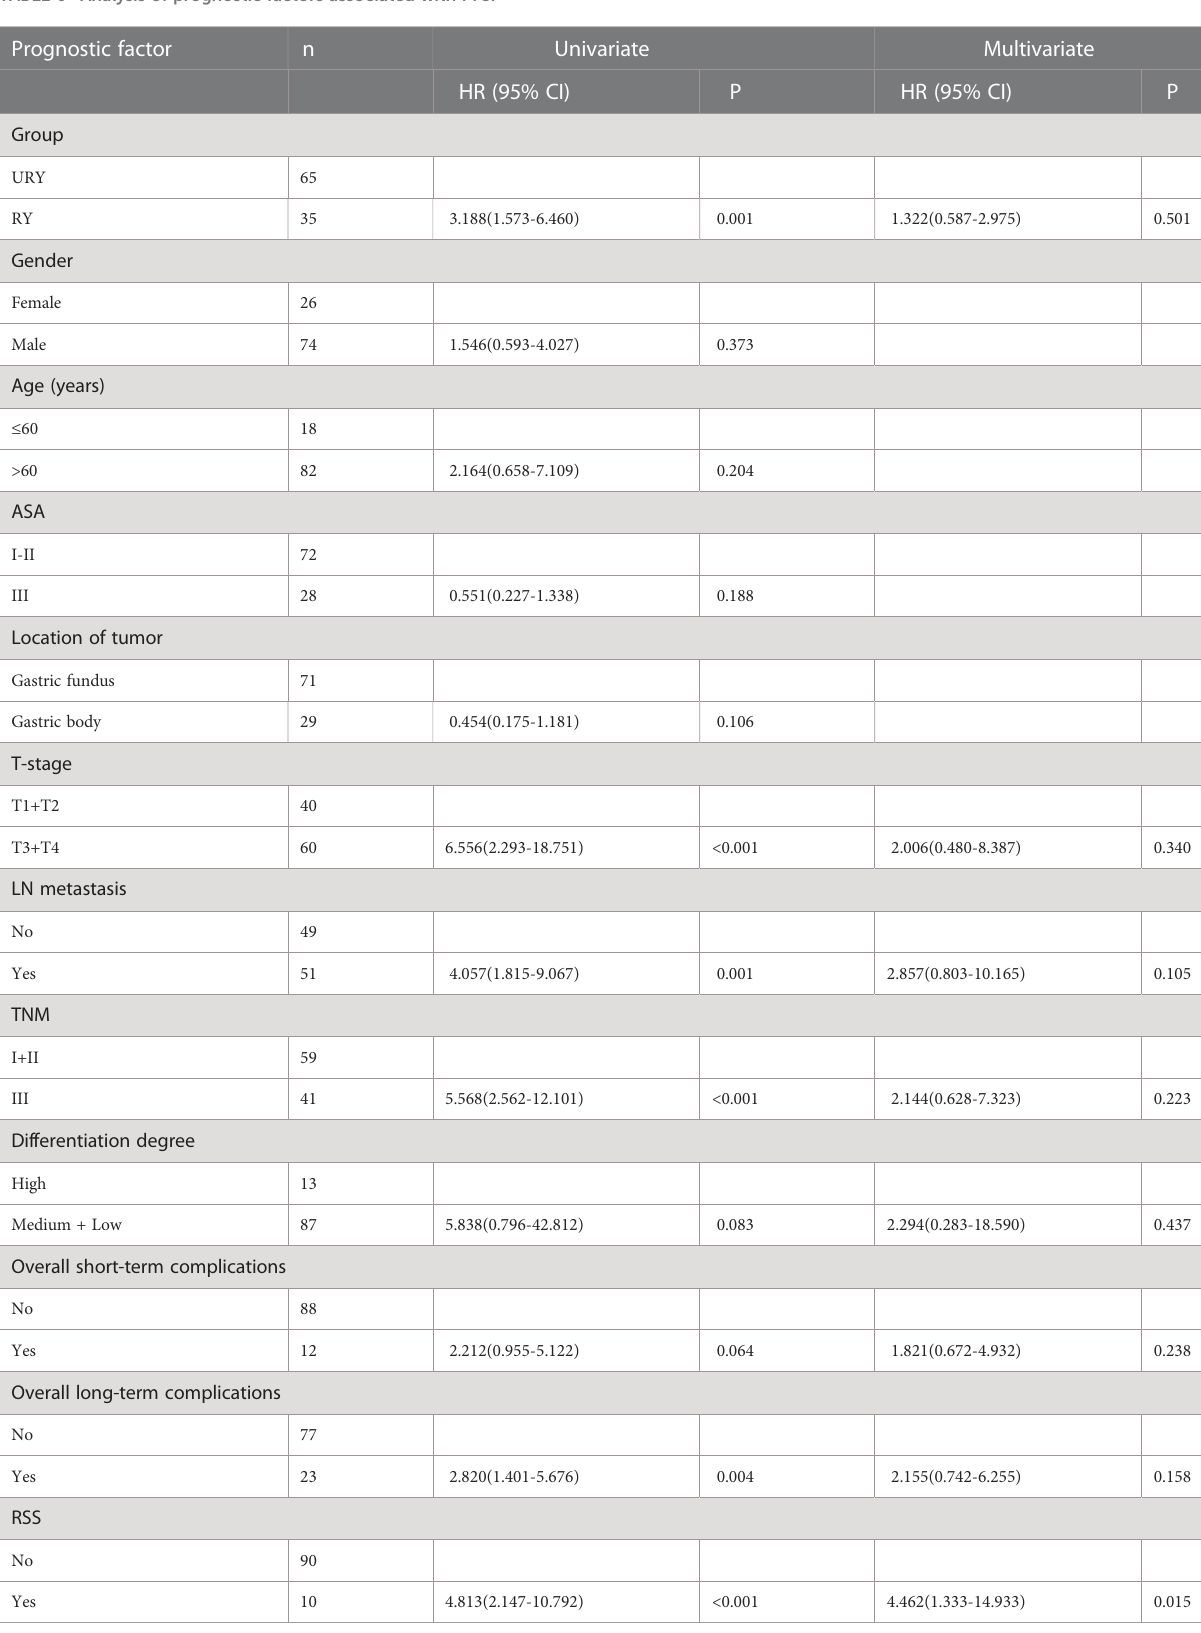
TABLE 6 Analysis of prognostic factors associated with